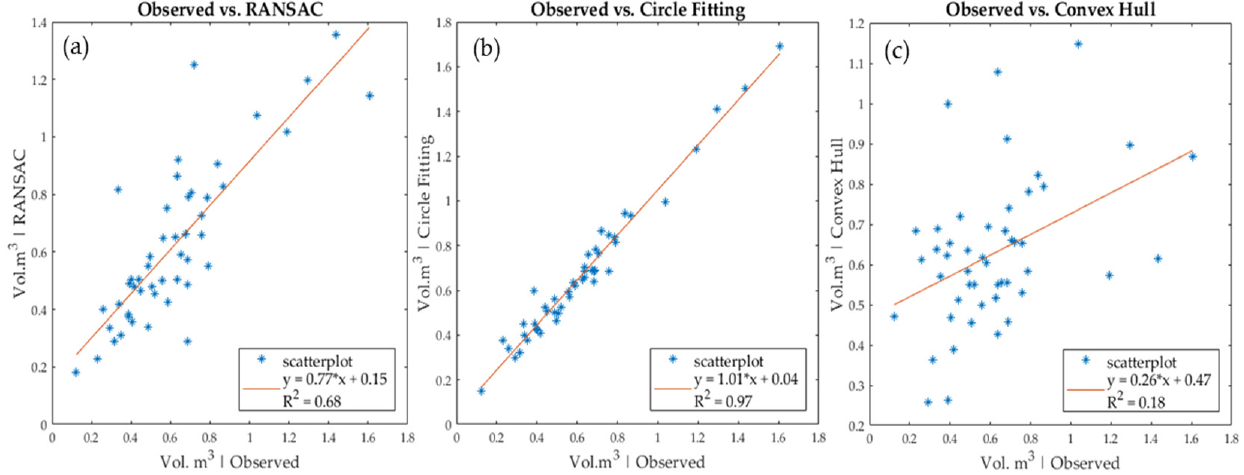
Figure 5 . Linear regression models of the observed and estimated total stem volume between the three used approaches. ( a ) shows the volume correlation between observed and RANSAC, ( b ) shows the volume correlation between observed and circle fitting, and ( c ) shows the volume correlation between observed and convex hull.